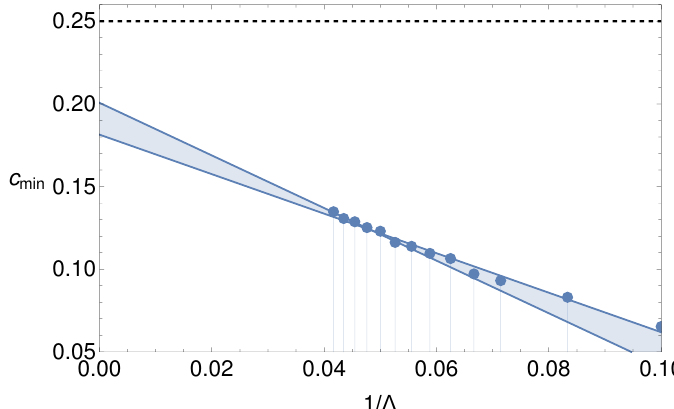
Figure 2 . Minimum allowed central charge from the correlation function of ^ B as a function of the inverse of the number of derivatives (cid:3). The dashed horizontal line marks the central charge of the U(1) N = 4 SYM theory. The two blue lines show linear (cid:12)ts to di(cid:11)erent subsets of points, in order to give very rough idea of where the bound is converging to with (cid:3) ! 1